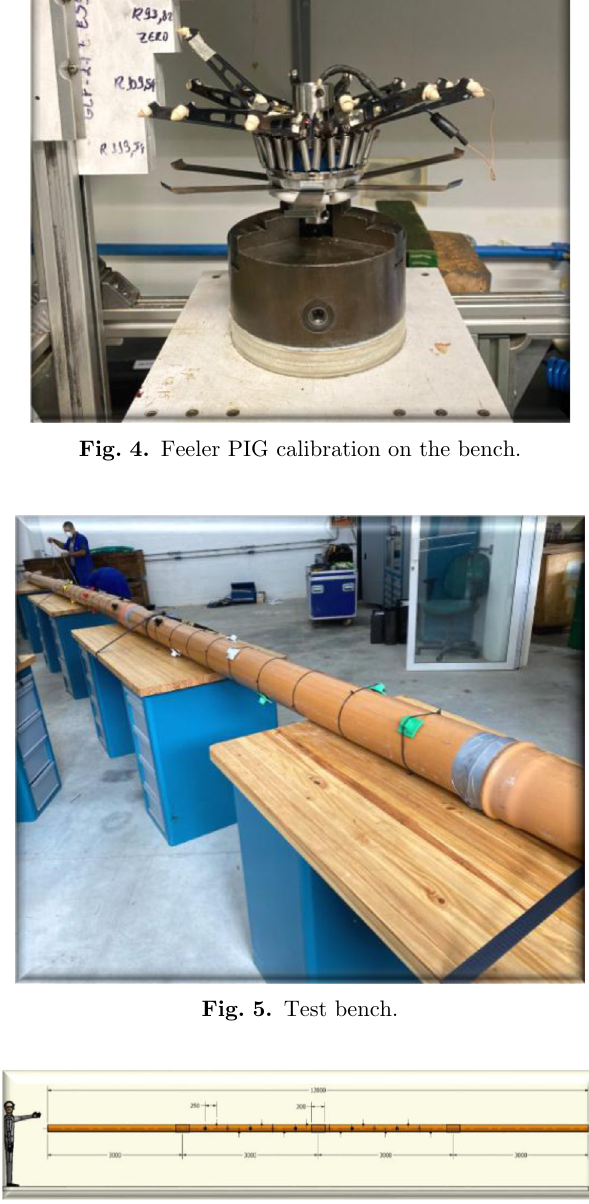
Fig. 6. Side view of the test bench with the